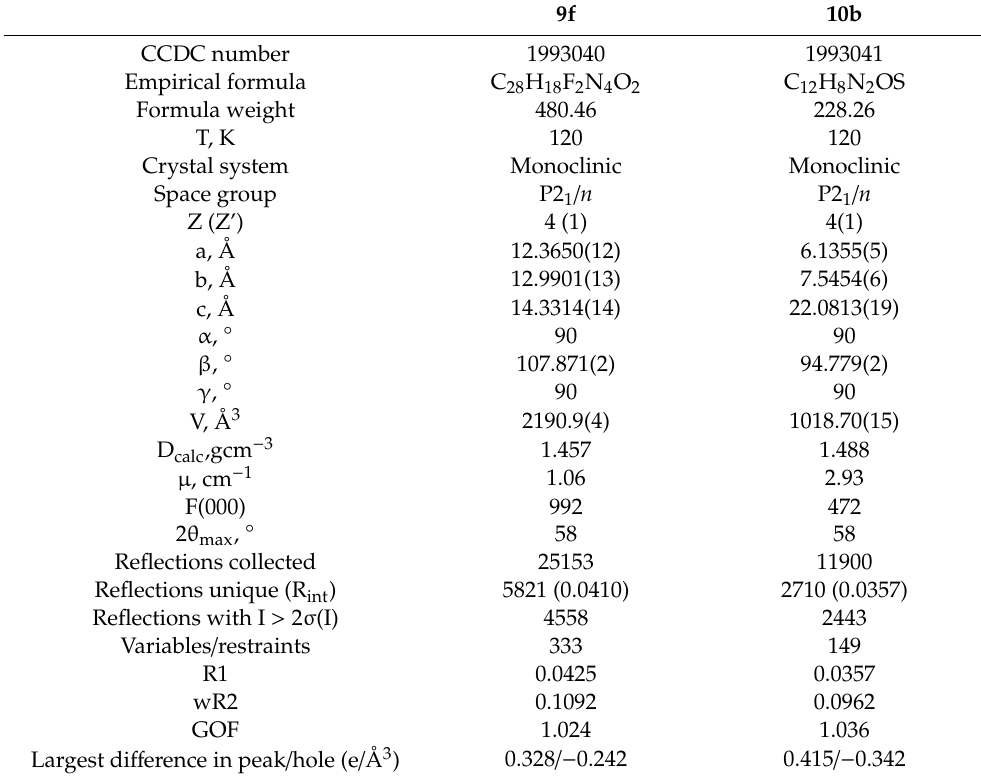
Table 1. X-ray crystallographic data and refinement details for studied